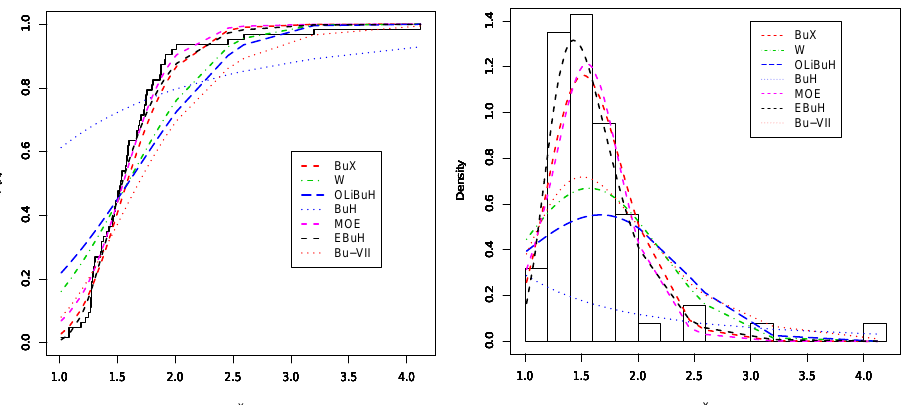
Figure 6. Estimated CDFs (left panel) and PDFs (right panel) of the EBuH distribution and other models for data set